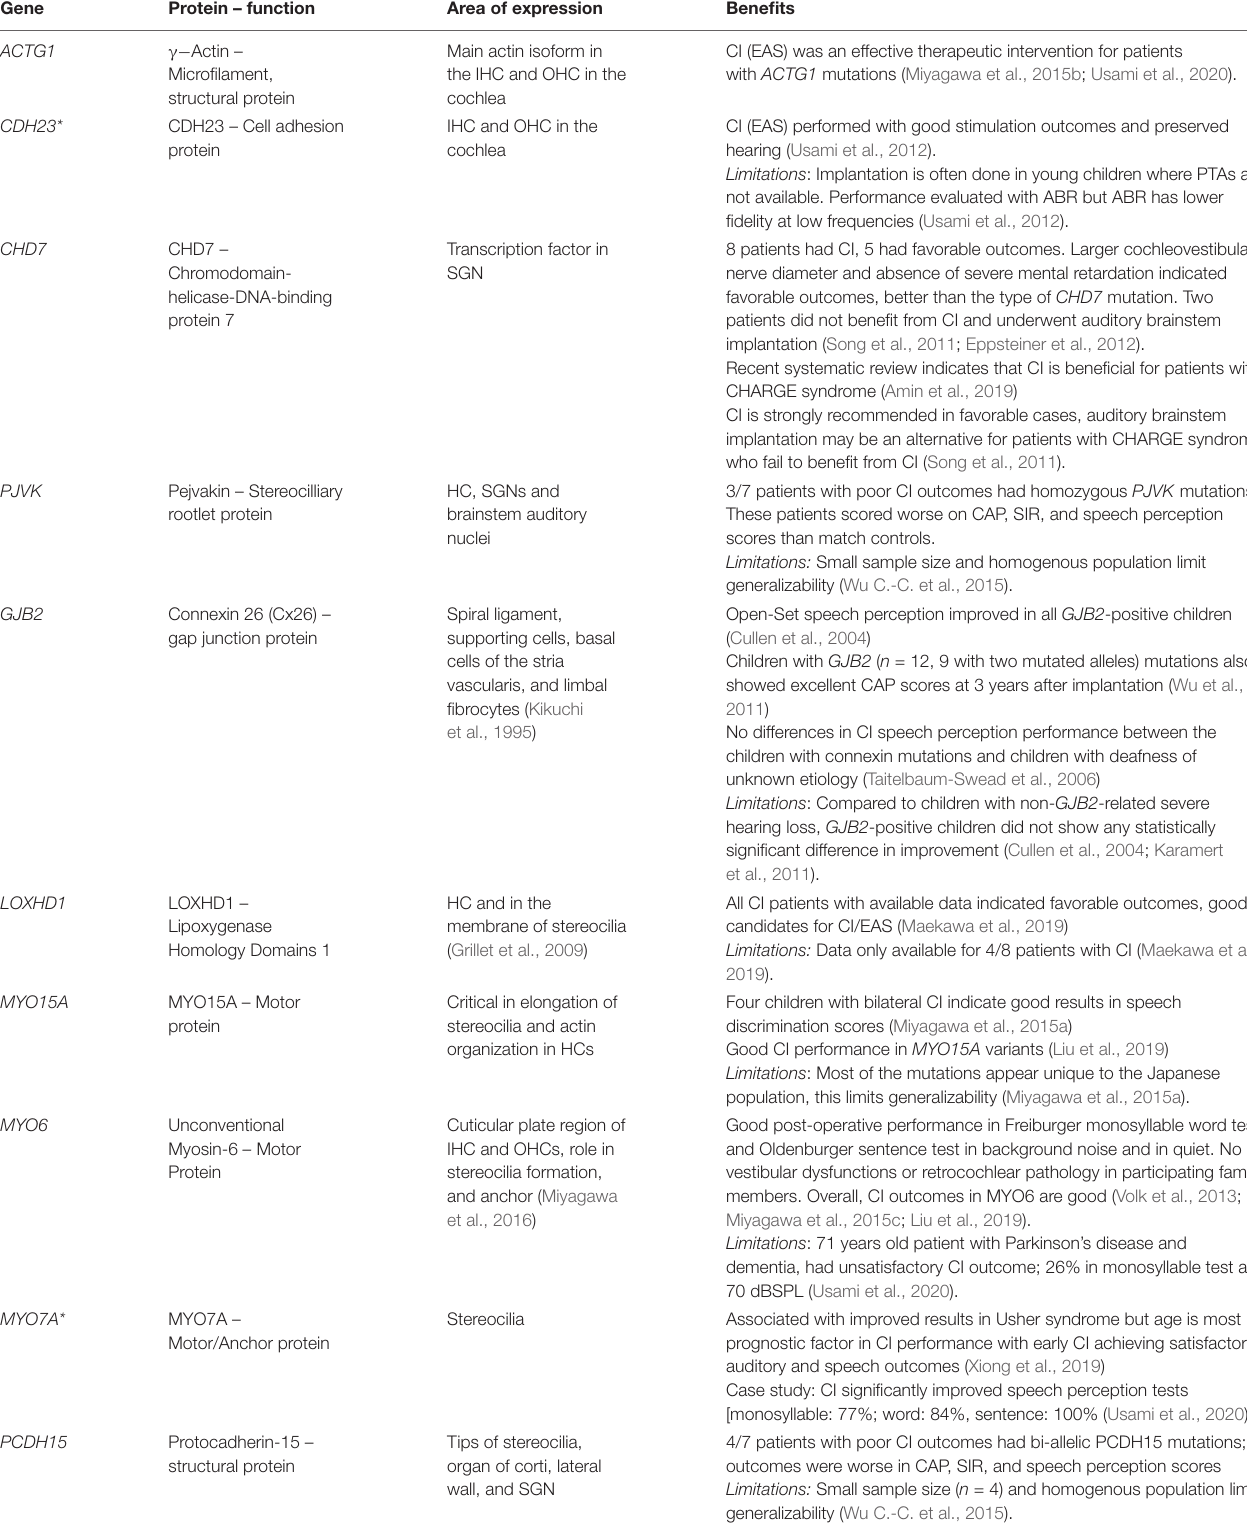
TABLE 1 | Genotype-phenotype correlation and cochlear implantation outcomes in most common causes of Non-Syndromic Deafness. Gene Protein –